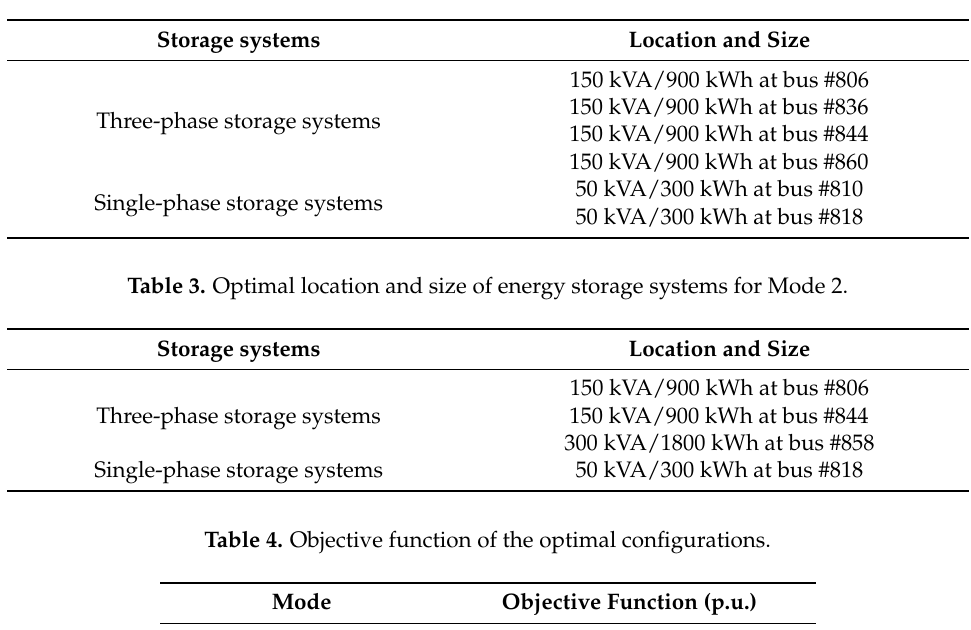
Table 2. Optimal location and size of energy storage systems for Mode 1.